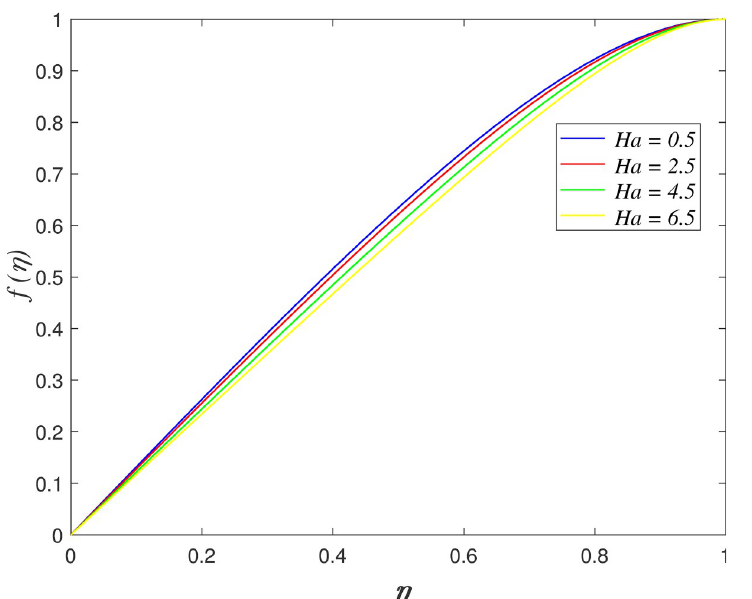
Fig 10. Impact of Ha on radial velocity.